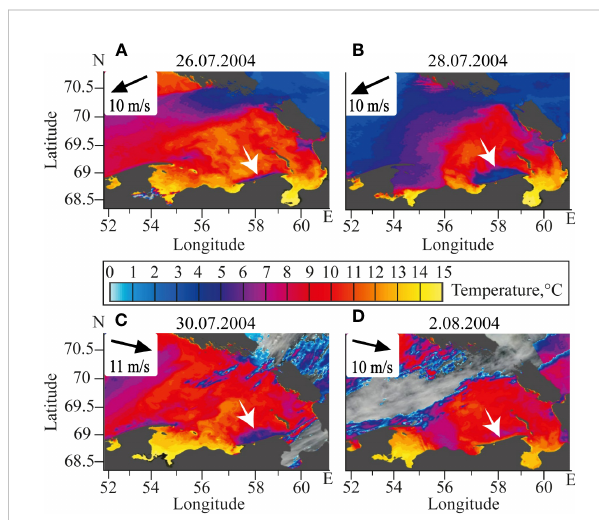
FIGURE 13 Satellite-derived Sea surface temperature in the Pechora Sea on 26 July 2004 (A) , 28 July 2004 (B) , 30 July 2004 (C) , 2 August 2004 (D) acquired by MODIS Terra/Aqua. Areas of upwelling events are indicated by white arrows. Dark grey color indicates land, white color indicates cloud coverage of the study area. Wind directions and velocities averaged during two days preceding the satellite image are shown in the